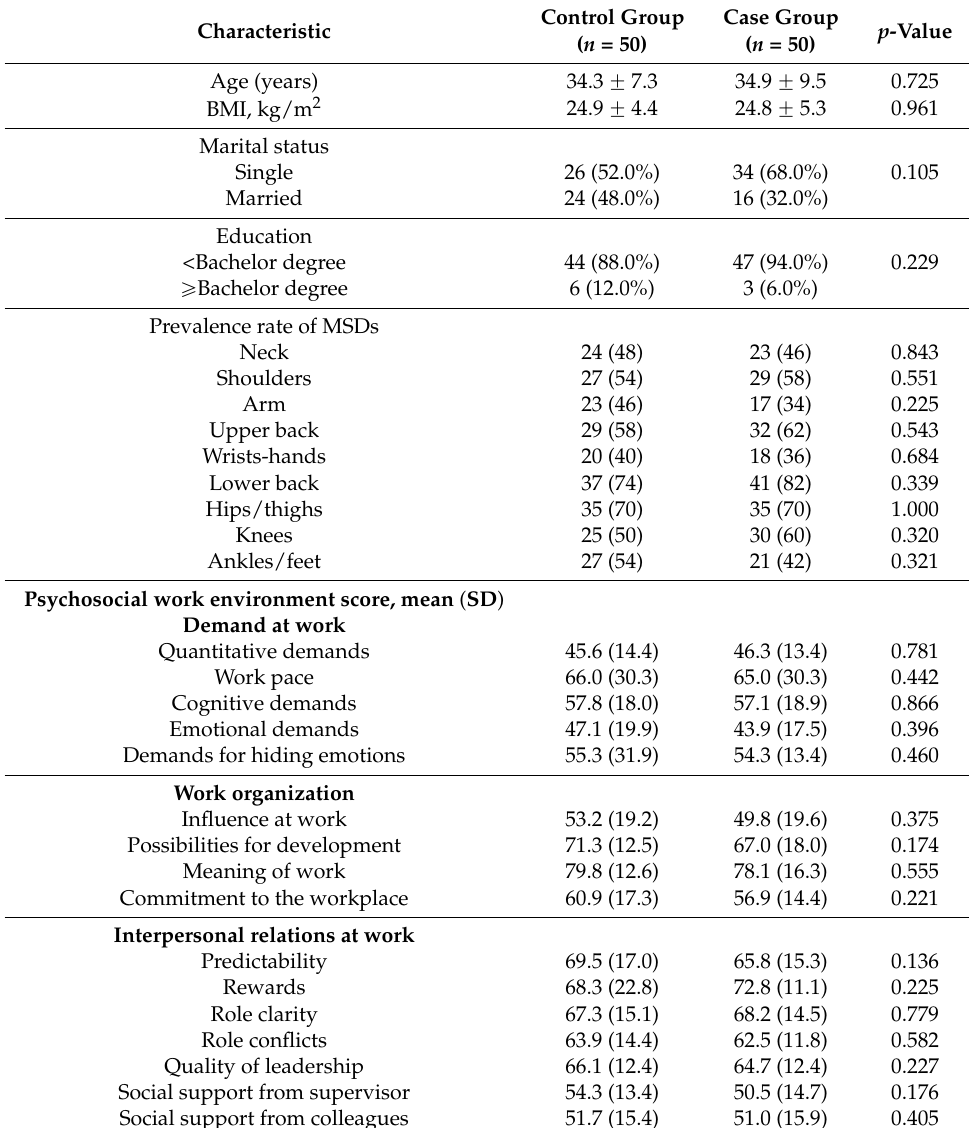
Table 1. Baseline characteristics of 100 hospital orderlies.